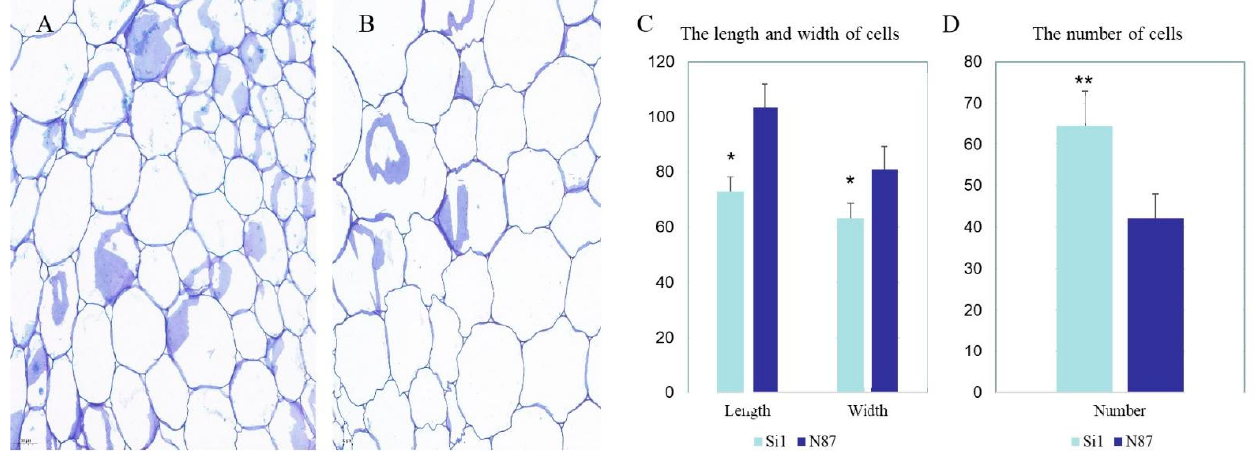
Figure 2. Cytological characterization of the parental lines Si1 and WT N87. ( A , B ), Longitudinal sections of the internodes of Si1 and WT N87. Bar, 50 μ m. ( C ), The length and width of parenchyma cells in stems of Si1 and WT N87. ( D ), The number of cells in the Si1 and WT N87 longitudinal sections. Error bars indicate standard deviations from three repeats ( n = 3). Values are means + SD ( n = 3). ** Significant at p < 0.01, * Significant at p < 0.05.